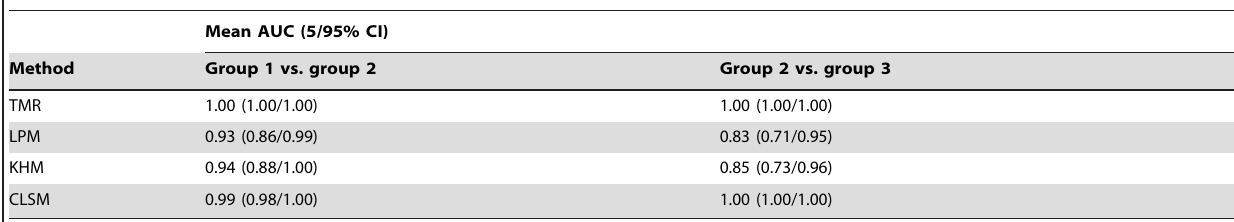
Figure 1. Bland-Altman plots. Differences ( D ) of measured substance loss between various methods were plotted against the mean measured values. Hatched line and dotted lines=mean and 95% Confidence Intervals of the difference. Solid grey line=zero-line. Solid black line=ordinary least square regression line. Relative bias between methods is indicated if p D , 0.05. The slope (R) of the linear regression line is given, and proportional bias was assumed if p , 0.05.